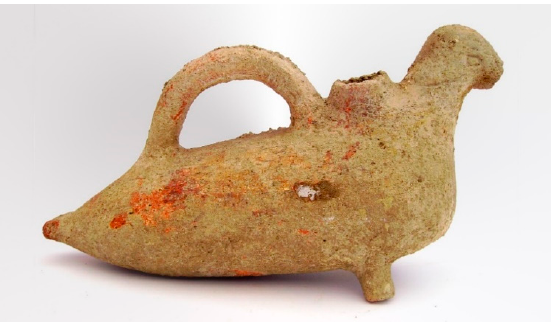
Figure 12. Two claws with part of bird’s tail beside human foot in sandal (MGW inv. no. 5419); marble sculptural pedestal; Roman period.